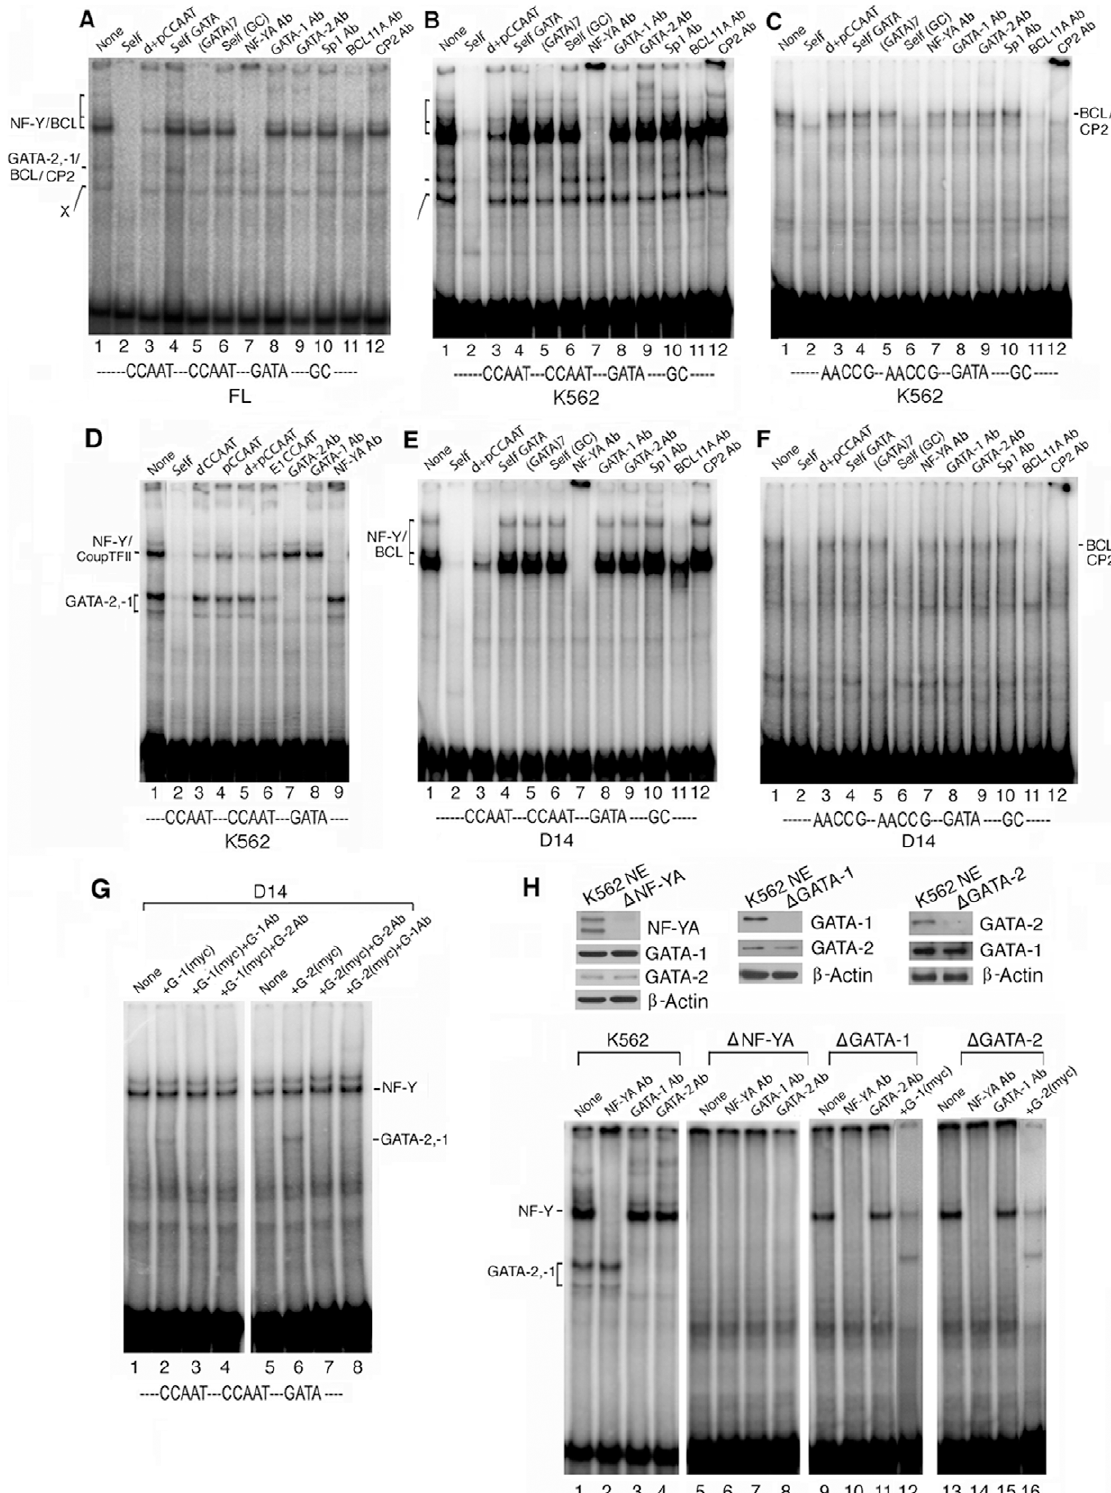
Figure 3. Identification of transcription factors that bind to the proximal c -globin promoter as determined by EMSA. A, B & E. Wt proximal c -globin promoter probe with nuclear extracts from human fetal liver, K562 cells and D14 adult erythroid cells, respectively. Top labels: Competitors and antibodies used in EMSAs. Self, self CCAAT, self GATA, (GATA)7 and self GC were respectively 100x molar excess of unlabeled probe, distal 2 115 and proximal 2 88 CCAAT motifs, the 2 73 GATA motif, seven tandem GATA motifs (29), and GC-rich bases spanning GGCCGG motif. Margin labels: bands generated by the transcription factors as marked. C & F. Mutant CCAAT proximal promoter probe with K562 and D14 nuclear extracts; all other labels were the same as in A . D. Binding affinity of COUP-TFII to its cognate site overlapping the distal CCAAT motif in the proximal